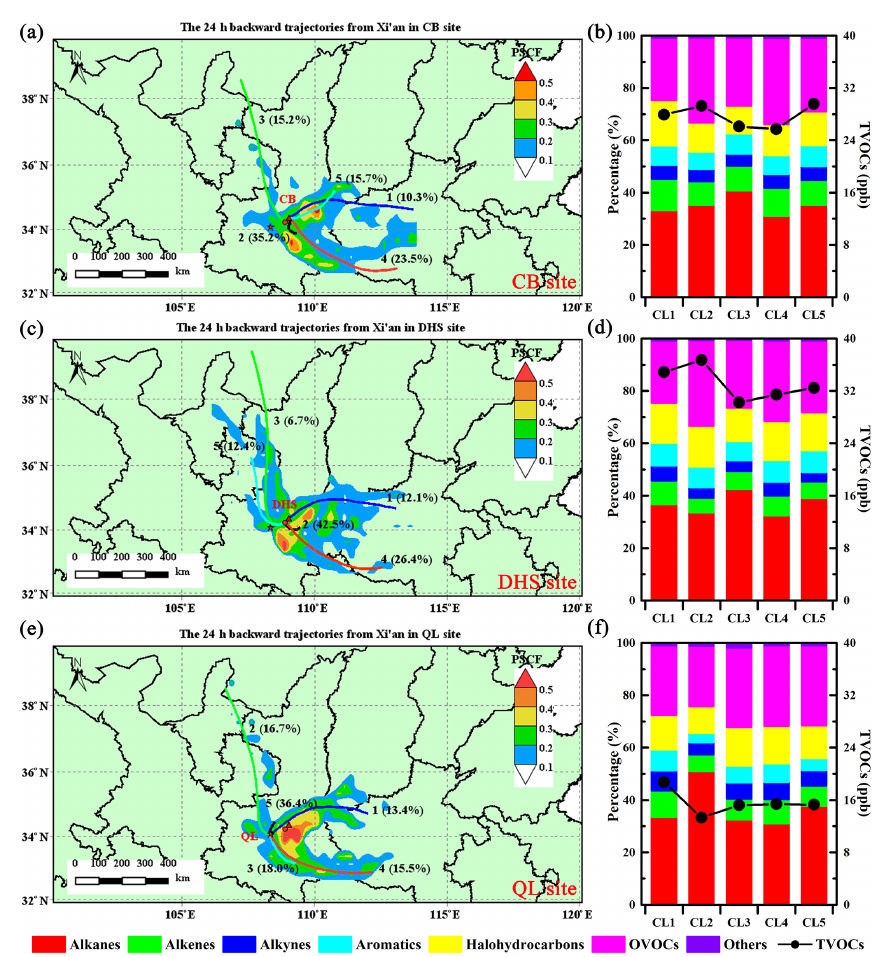
Figure 10. Backward trajectory cluster analysis (24h) and PSCF analysis in the CB, DHS, and QL sites.